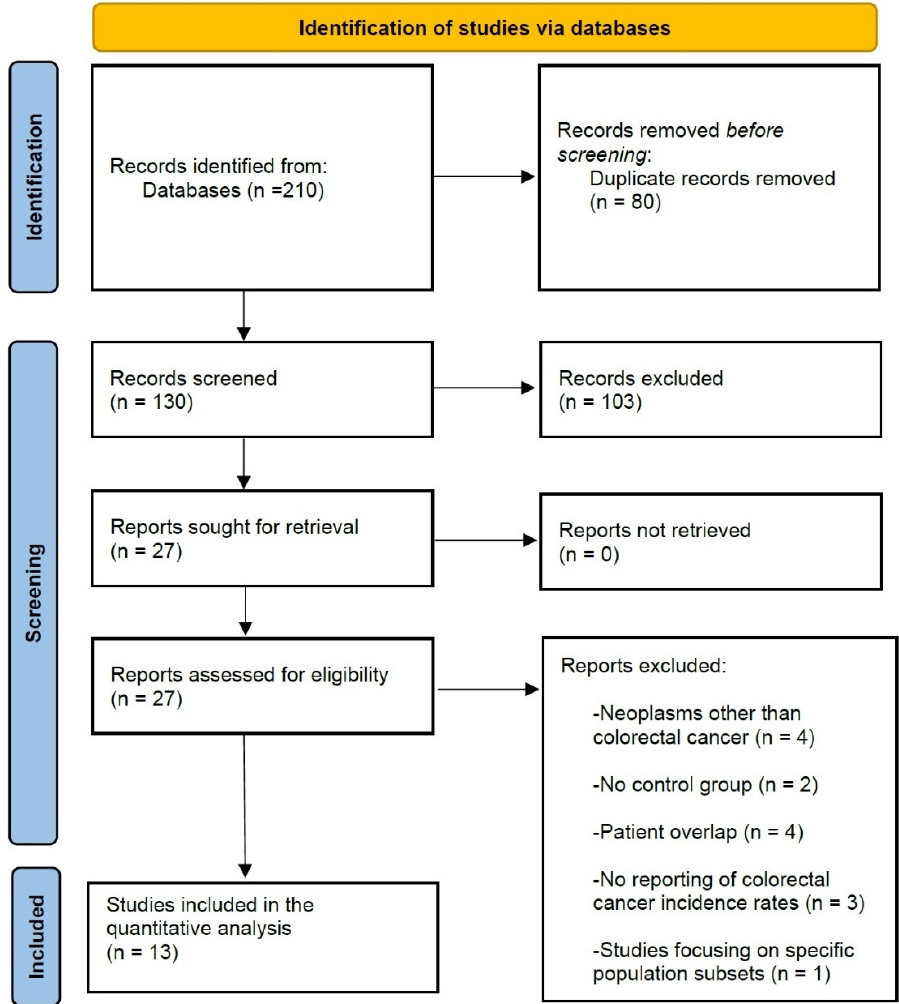
Figure 1. Prisma flowchart of study selection.